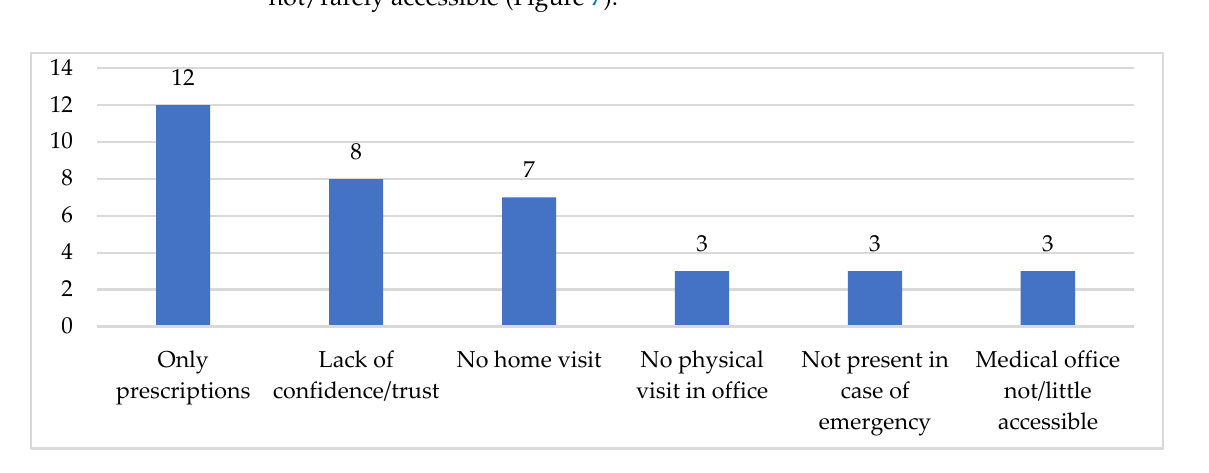
Figure 7. Reasons supporting a bad relationship with GP (n). Some respondents reported more than one type of listed reasons.